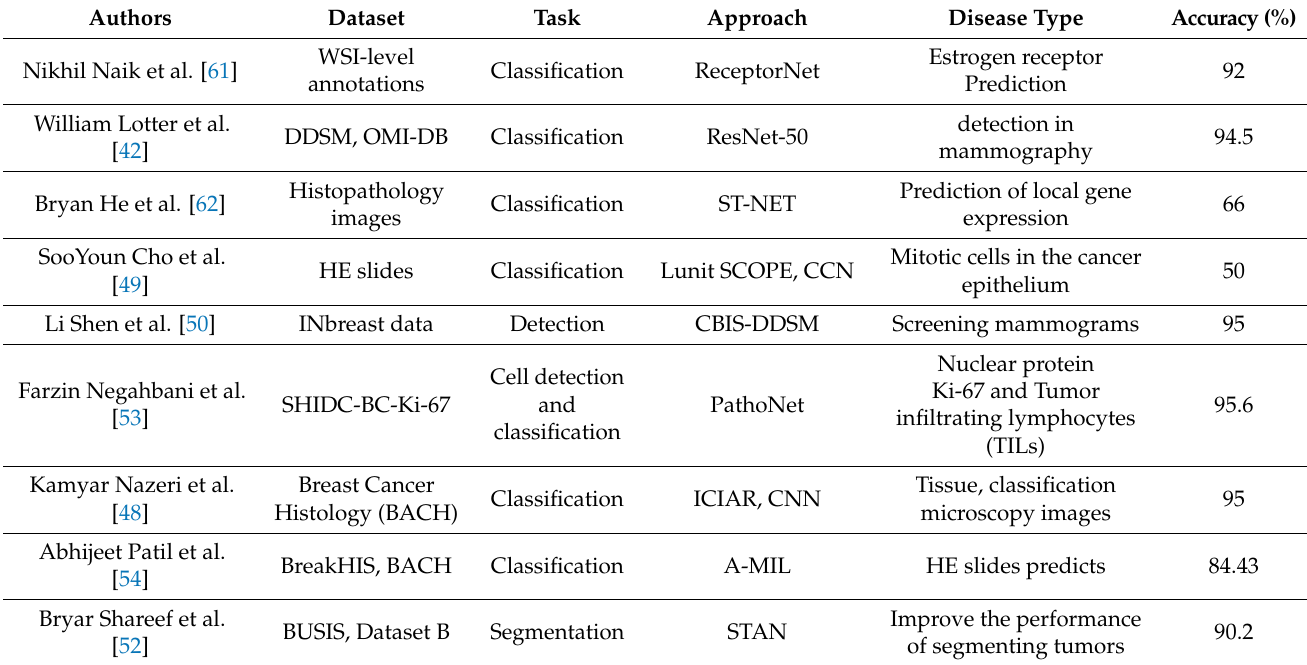
Figure 10. Proposed TopoTxR Method. Table 2. Summary of reviewed articles.